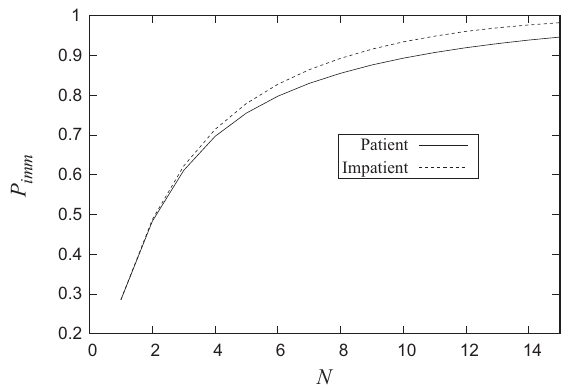
Figure 6. Dependence of the probability P imm on the number N .